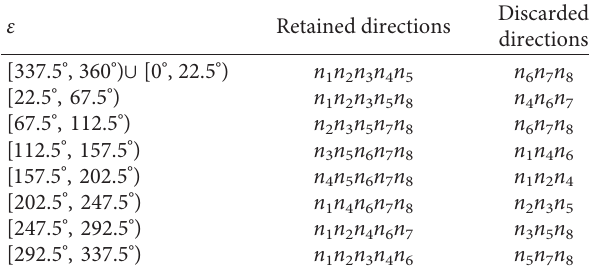
Discarded directions